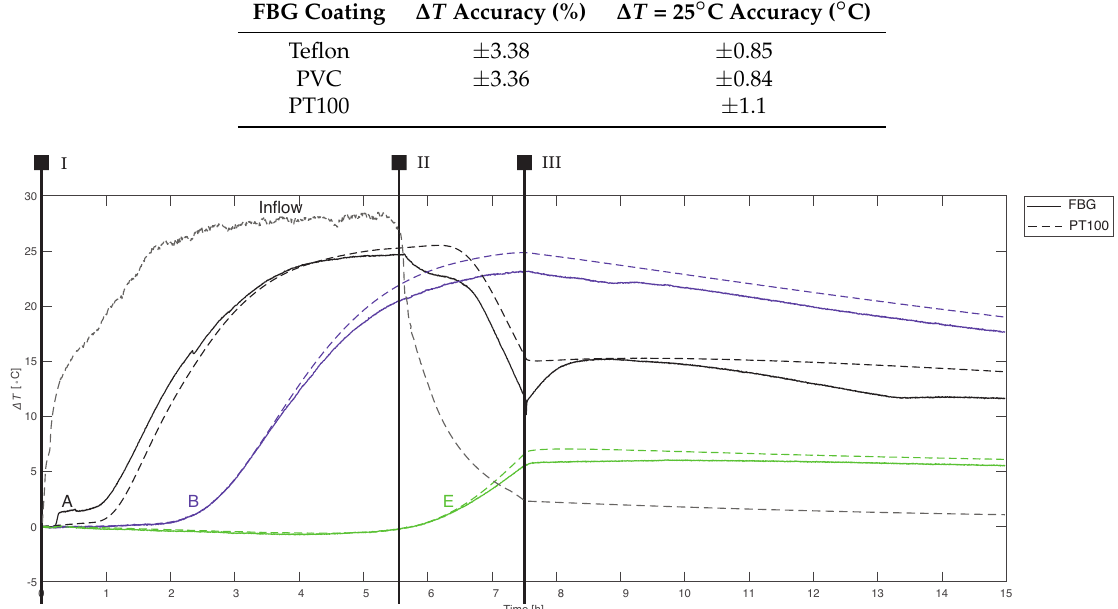
Figure 6. A comparison of the FBG data translated into temperatures with the PT100 temperature profiles: The displayed data are from the sensors highlighted in Figure 3. Identical colors indicate sensors in the same row on the frame (the same distance from the inflow system). Experimental stages: I—hot inflow, II—cold inflow, and III—no